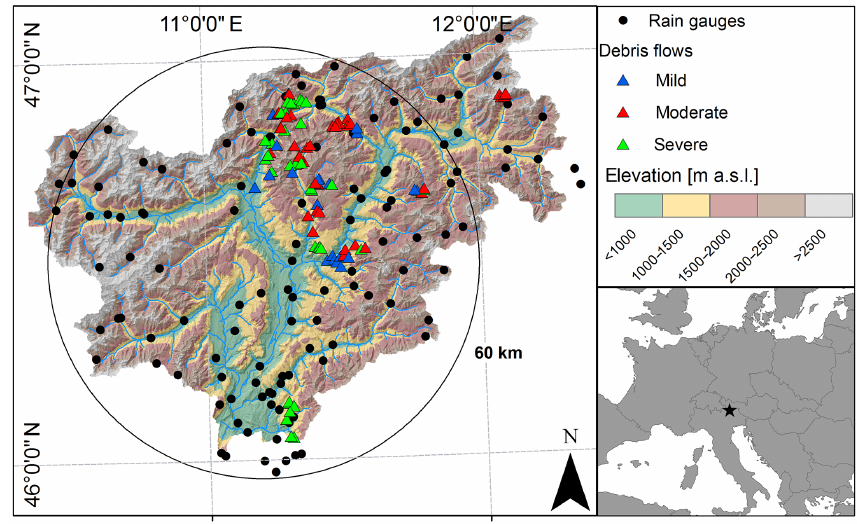
Figure 1. Map of the study area including terrain elevation, rain gauge network (dots), and debris flows included in the study (triangles). Location of the study area within Europe is